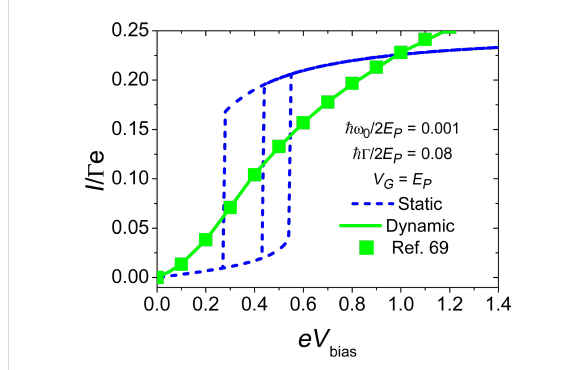
Figure 5: Electronic transport properties within the range of validity of the adiabatic approximation. Current ( e Γ units) voltage ( eV bias in units of 2 E P ) characteristic of the device. Solid (green) curve is drawn from [69], squares indicate the results of the semiclassical adiabatic ap- proach adopted in this paper and dashed (blue) line indicates the I – V bias in the infinite mass static approximation. Adapted from